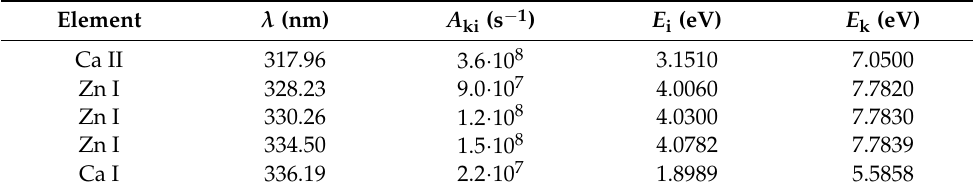
Figure 2. ( a ) The average signal-to-noise ratio of 10 consecutive measurements of BAM 308. Each measurement is a 5 × 5 map, where one spectrum was accumulated from five pulses in one spot. Signal-to-noise ratio (SNR) was calculated in each spectrum as the ratio of Zn I 334.50 nm intensity and respective background in the proximity of analytical line. Then, each point in the plot was statistically obtained as an average of SNR values from 25 spectra. ( b ) The signal-to-noise ratio of zinc solution drop on soft tissue represented by 12 data points, seven red ones (analyzed on 12 July 2019) and five blue ones (analyzed on 23 September 2019). Each SNR in the graph is an average value of SNR from spectra related to one Zn drop. It is not possible to add error lines because SNR is influenced by heterogenous distribution of analyte concentration, therefore, only the average values can be compared. The signal-to-noise ratio for zinc solution drop on soft tissue was also assessed (Figure 2b). The latter case was achieved by a consecutive analysis of 12 tissue slices,